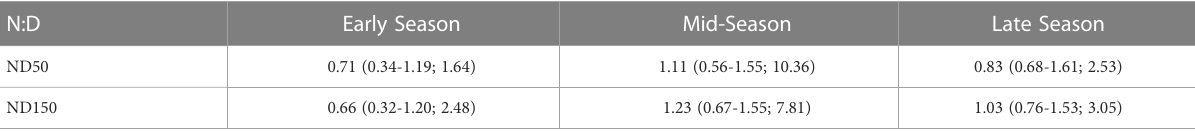
TABLE 4 Median (25 th and 75 th quantiles; maximum) of night:day ratios of integrated salp NASC (calculated from integrated PRC NASC) in the top 50 m (ND50) and top 150 m (ND150) of the water column during the early, mid, and late seasons. N:D